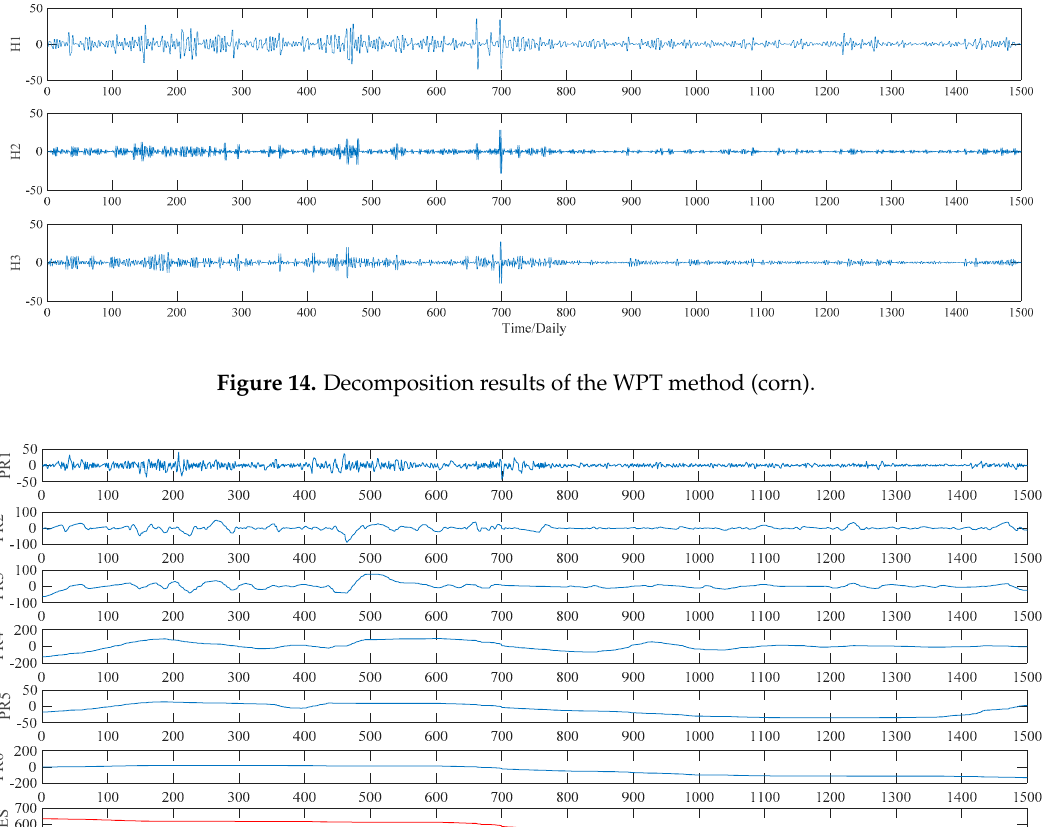
Figure 16. Decomposition results of the VMD method (corn). Figure 17. One-day-ahead forecasting results of different models of corn.